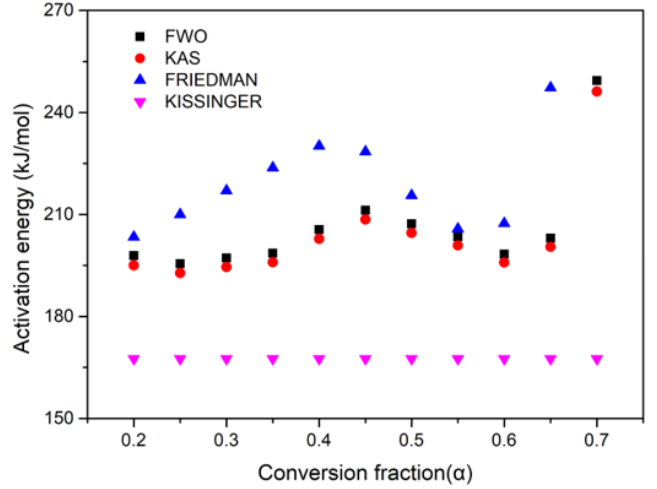
Figure 6. Activation energy of chicken manure obtained through FWO, KAS and Kissinger methods at different conversion rates.